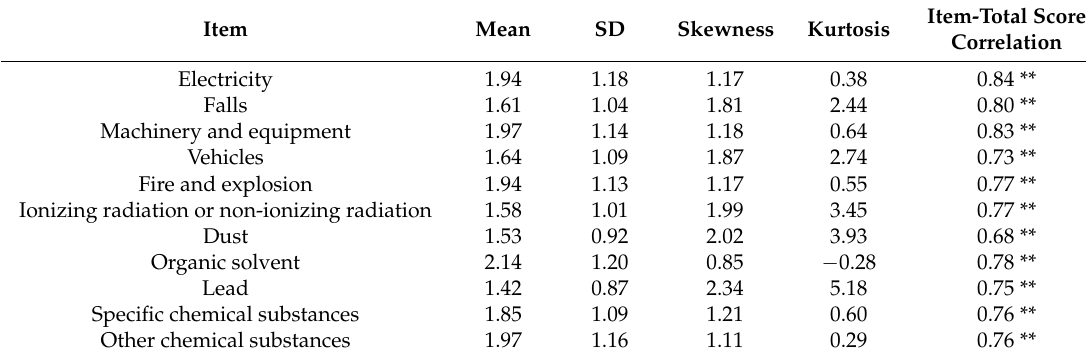
Table A1. Item analysis result for hazard management